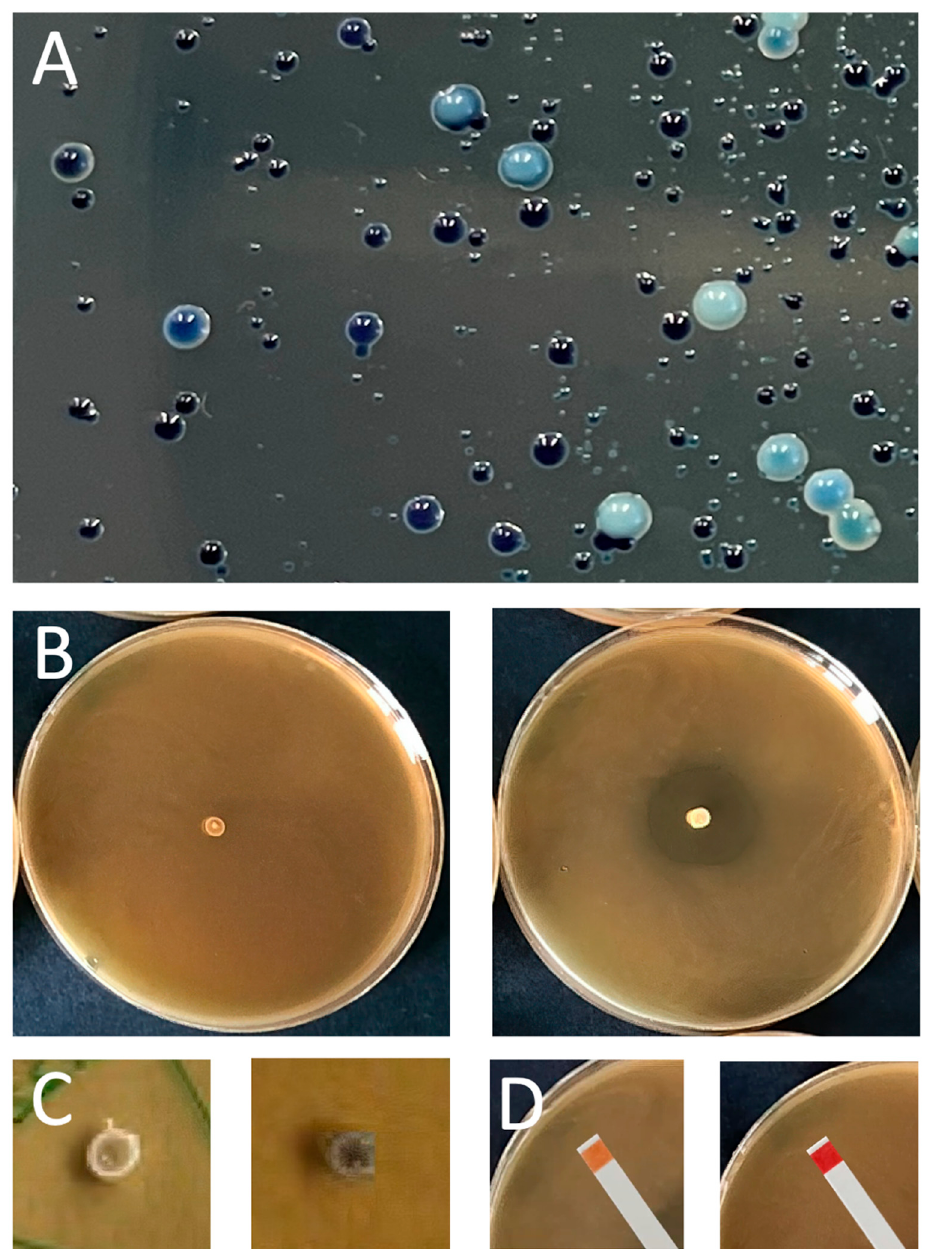
Figure 2. Lactic acid bacteria: ( A ) Diverse blueish colonies of LAB species on mMRS-BPB differential agar. ( B ) In point inoculation assay of LAB (center colony) against a pathogenic indicator strain (bacterial lawn). Left without zone of inhibition (no bacteria-killing activity), right with zone of inhibition (bacteria-killing activity). ( C ) Detection of hydrogen peroxide with TMB; left, light colony showing no secretion; right, blue colony indicating secretion. ( D ) Detection of acid production by LAB (MRS agar plates); pH stripes: orange, acidification to pH 4.1; red, no acidification pH 6.1.